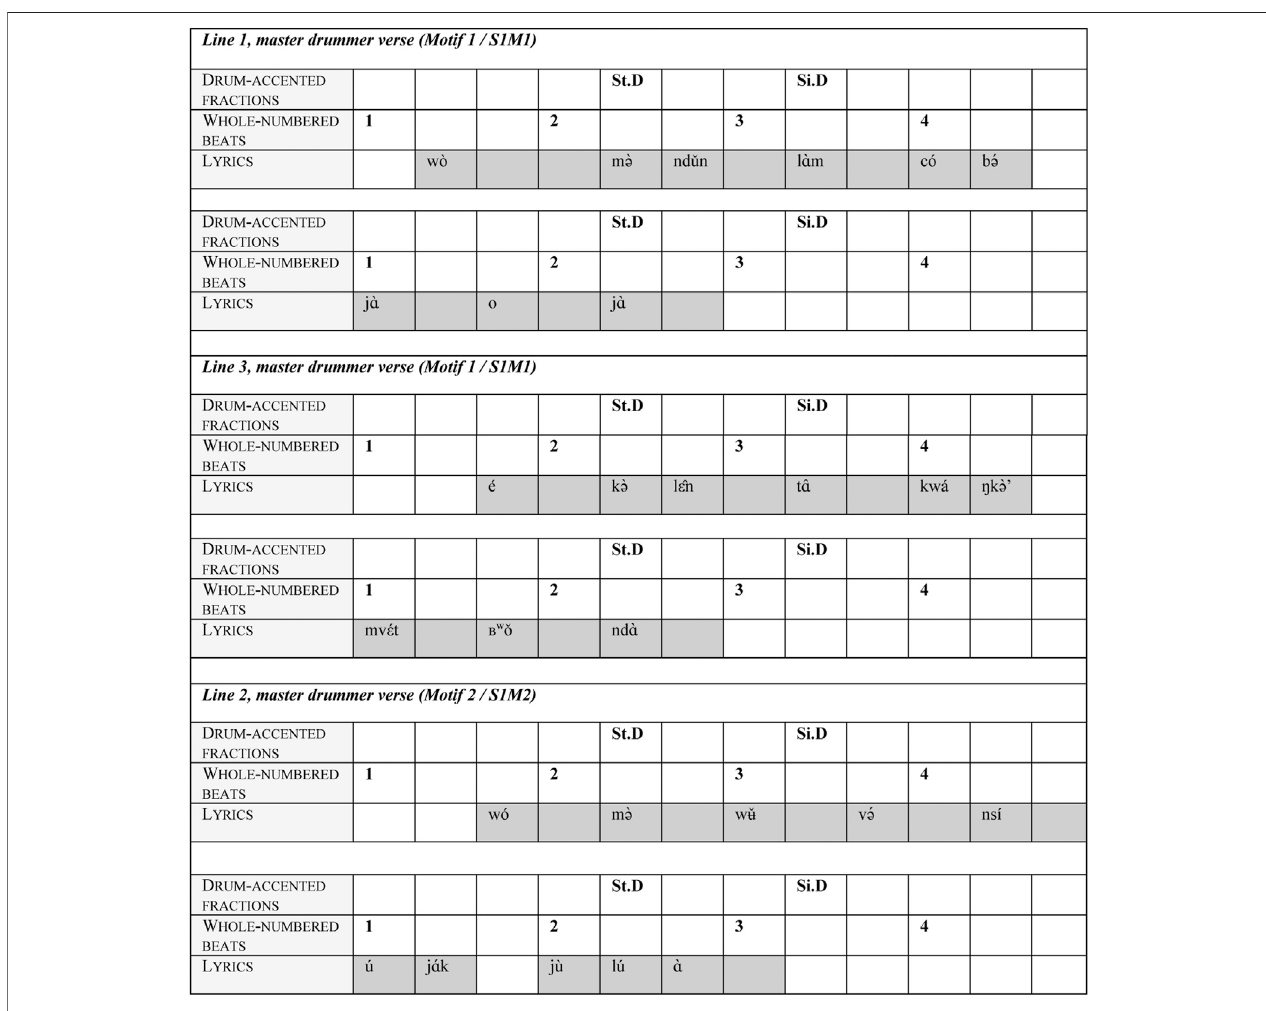
FIGURE 10 | Grid representation of three lines of master drummer ’ s verses, Song 1. Numbers 1 — 4 represent whole-numbered beats on which the idiophone/ shaker sound and dancers move. Individual cells represent beats on which the complex ndu (cid:3) nla ̀ m/metallophone sounds. St/Si represent beat fractions on which the Standing or Sitting drum sounds. Gray fi lled cells indicate beats on which the voice is